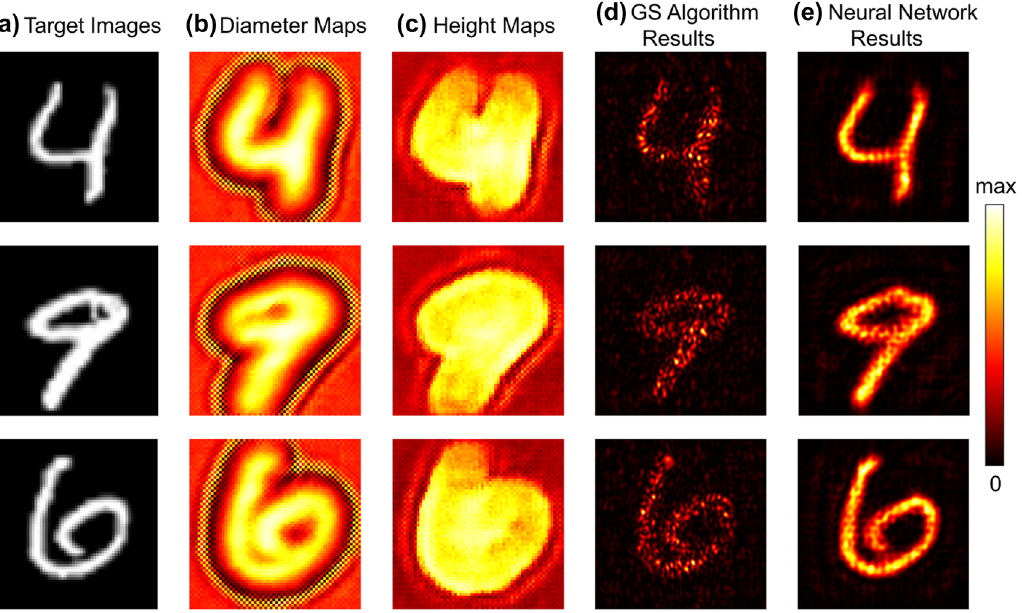
Figure 6: Testing results of the proposed physics-driven neural network compared with GS algorithm. (a) The target images. (b) and (c) The inverse design for diameter maps and height maps of metasurface-based holograms by the proposed neural network, respectively. (d) FDTD results of the reconstructive images from GS algorithm and (e) the proposed neural network, respectively, at a given distance of 24